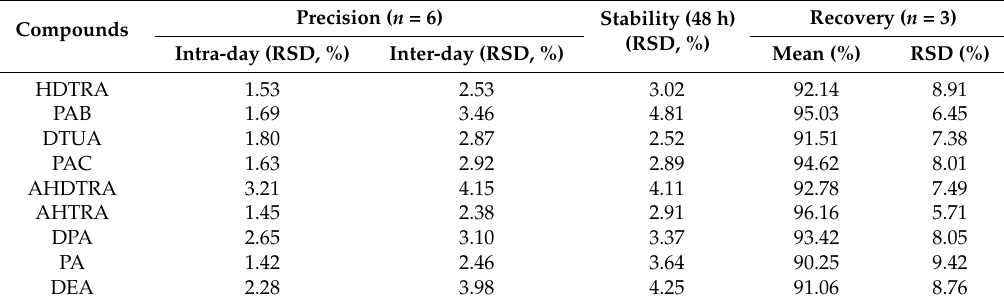
Table 2. Precision, stability and recovery of investigated triterpene acids.